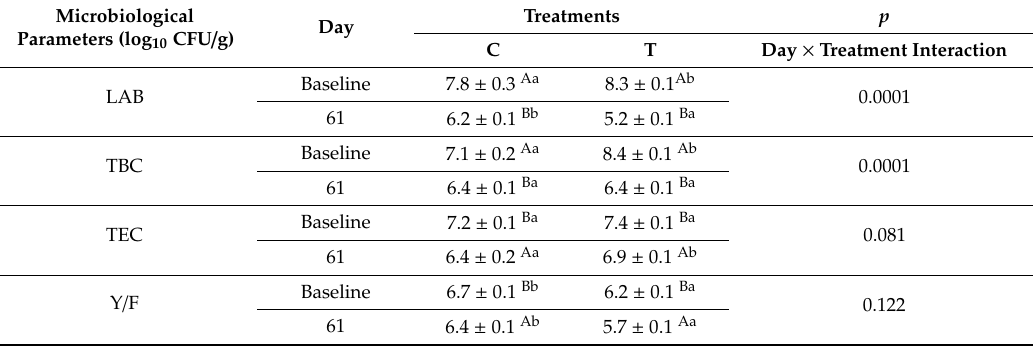
Table 2. Microbiological parameters in feces from 25- and 61-day-old